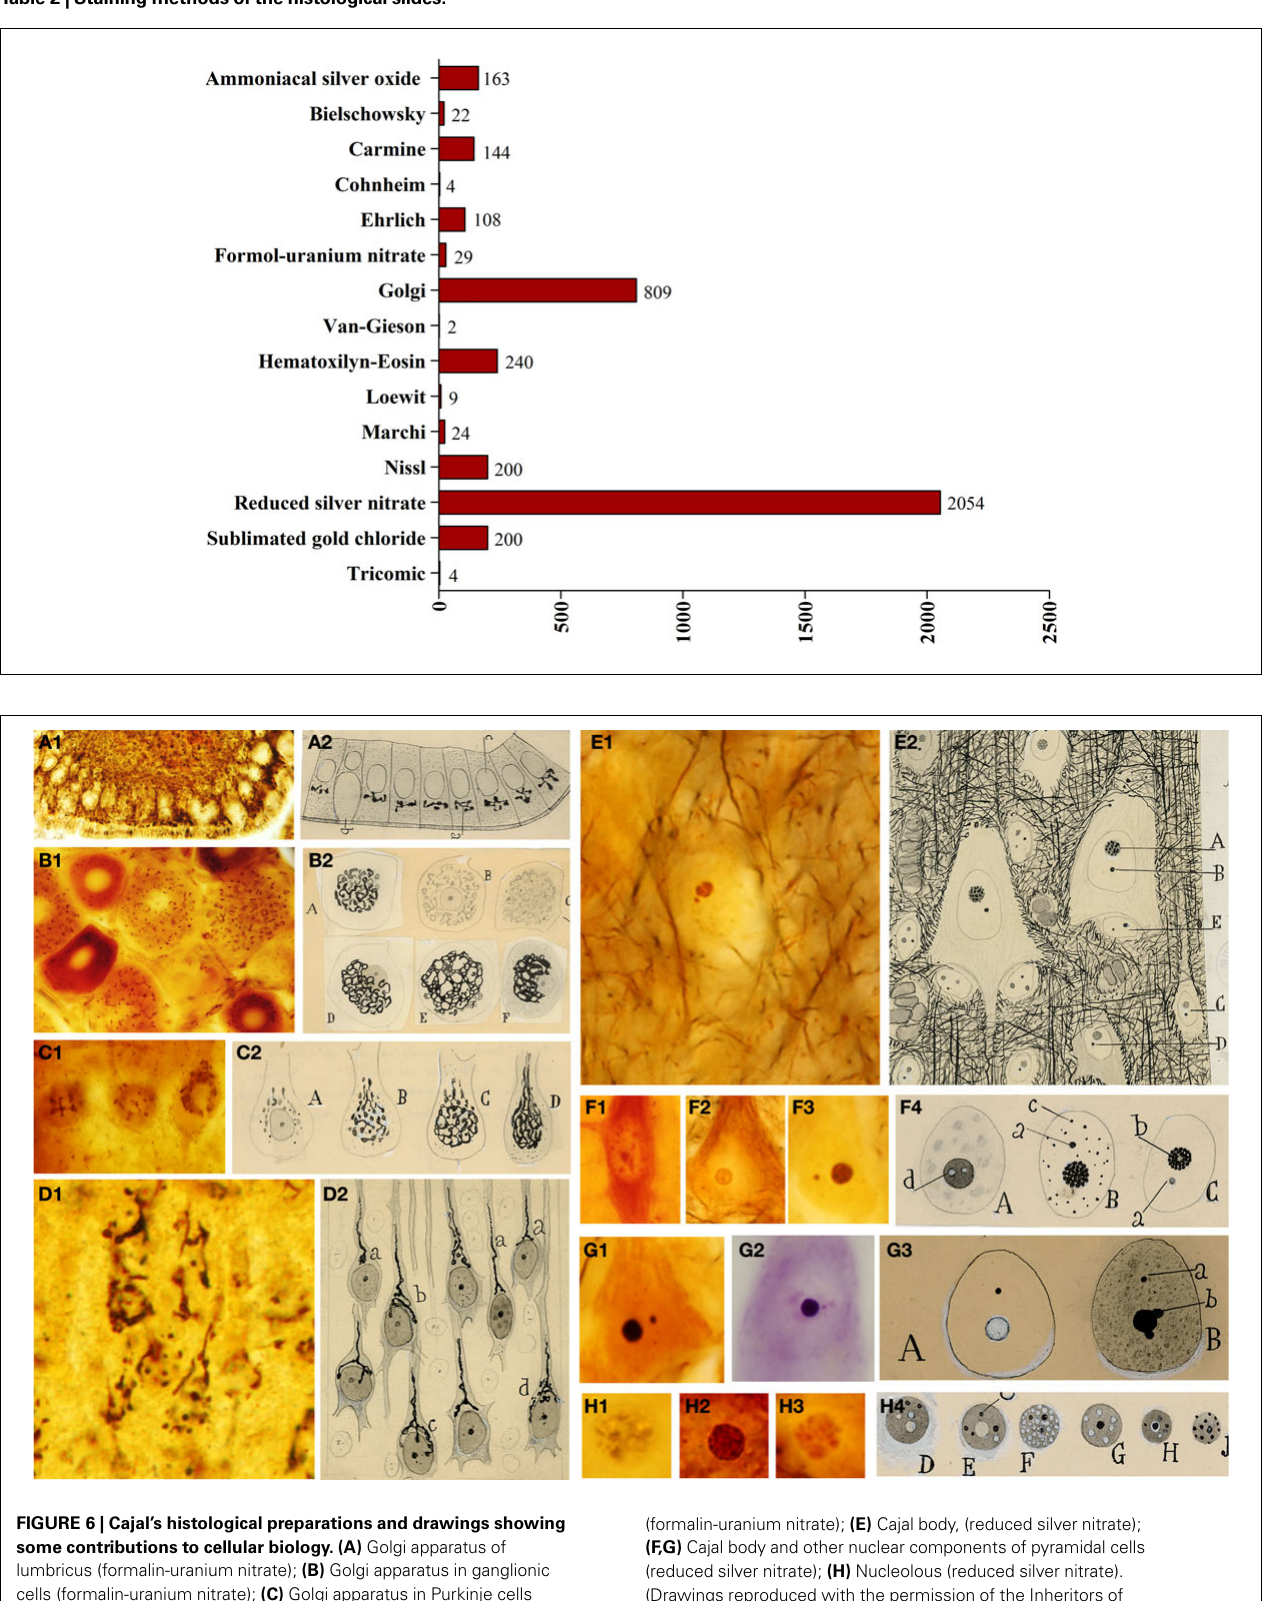
(formalin-uranium nitrate); (E) Cajal body, (reduced silver nitrate); (F,G) Cajal body and other nuclear components of pyramidal cells (reduced silver nitrate); (H) Nucleolous (reduced silver nitrate). (Drawings reproduced with the permission of the Inheritors of Santiago Ramón y Cajal